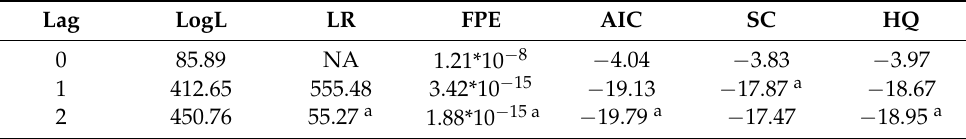
Table 3. Selection of optimal lag order.